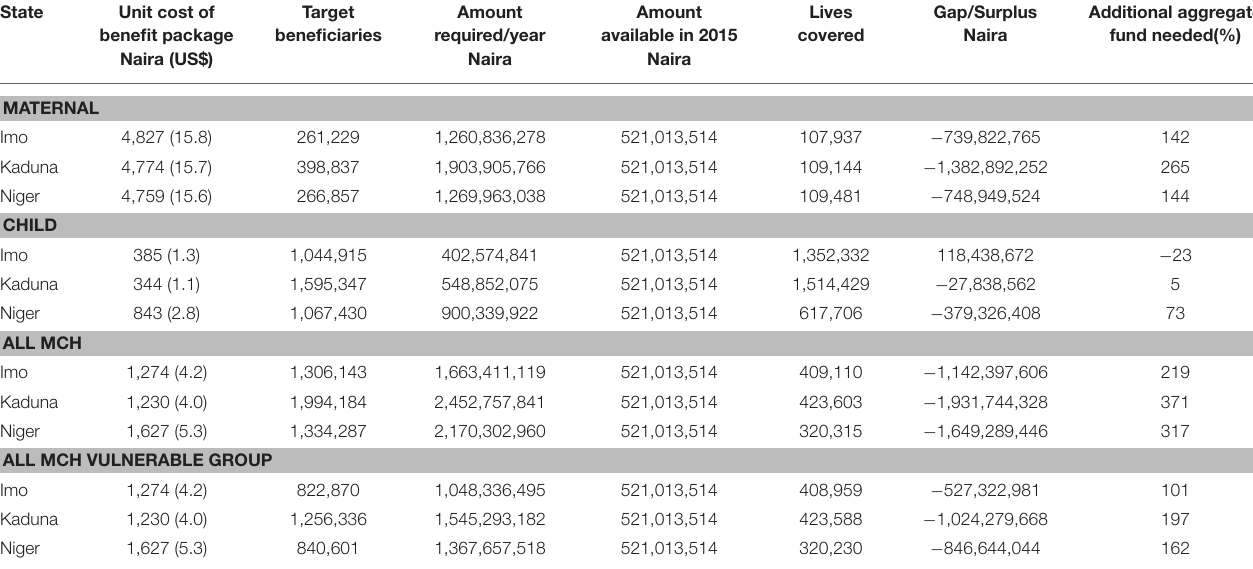
TABLE 6 | Scenario: 1a (Revenue: 50% of BHCPF).